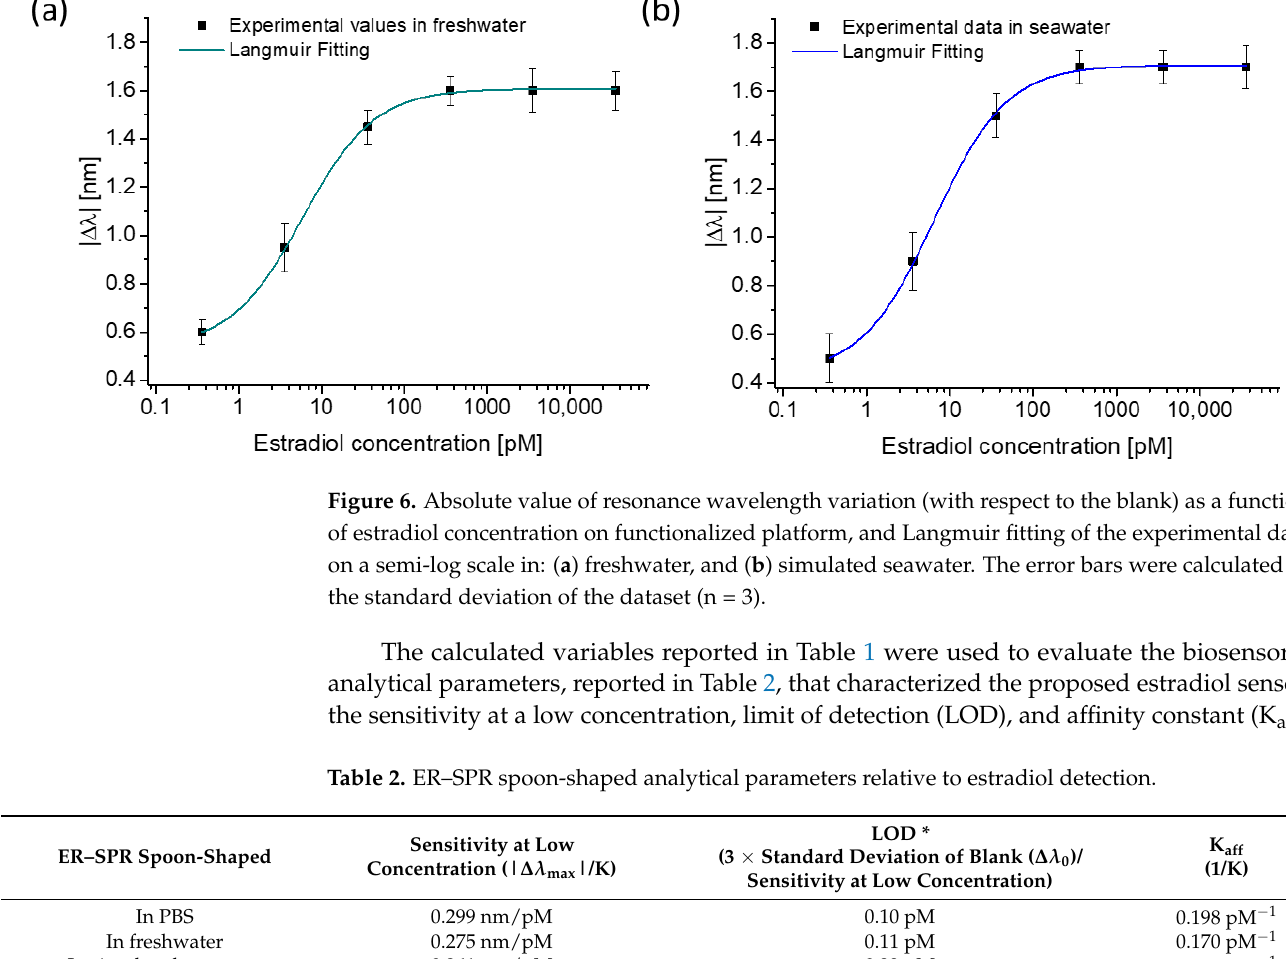
Table 2. ER–SPR spoon-shaped analytical parameters relative to estradiol detection.